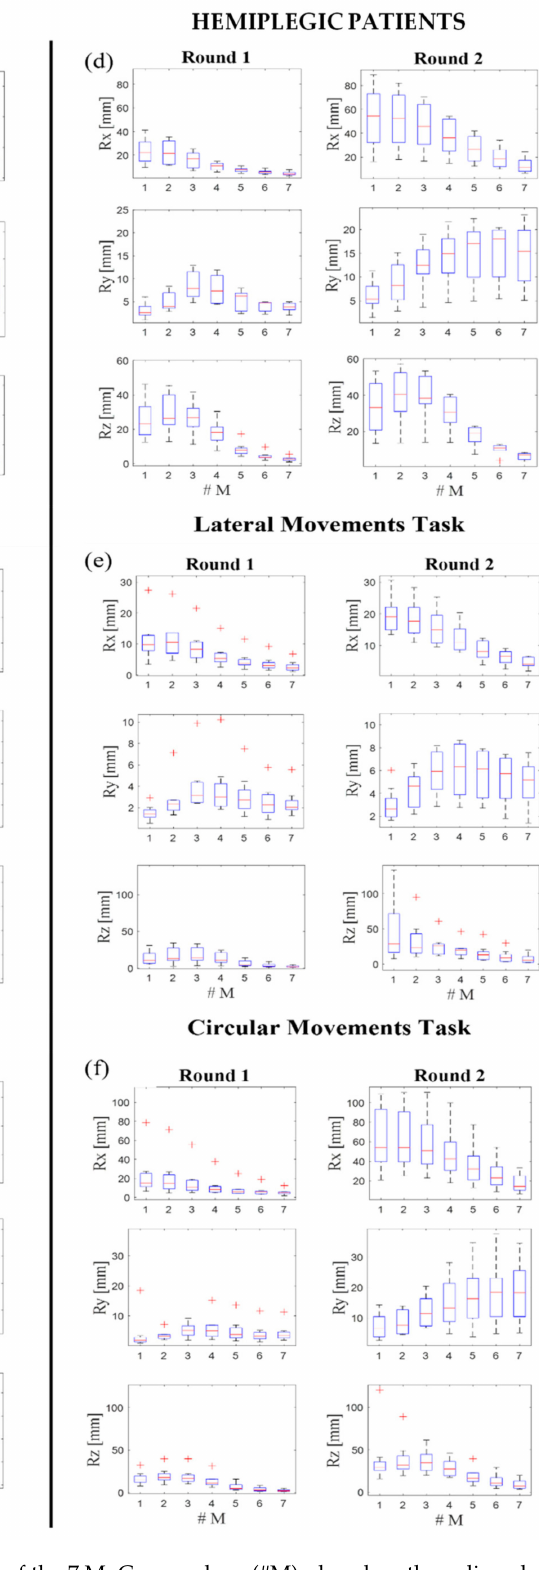
Figure 8. Relative displacements of the 7 MoCap markers (#M) placed on the spline along x ( Rx )-, y ( Ry )-, and z ( Rz )-axes during the three tasks (forward movements in ( a ) and ( d ), lateral movements in ( b ) and ( e ), and circular movements in ( c ) and ( f )), performed by the healthy volunteers (left column) and hemiplegic patients (right column), in the presence (Round 1) and absence (Round 2) of CTMs. Data are expressed as median, IQRs, and